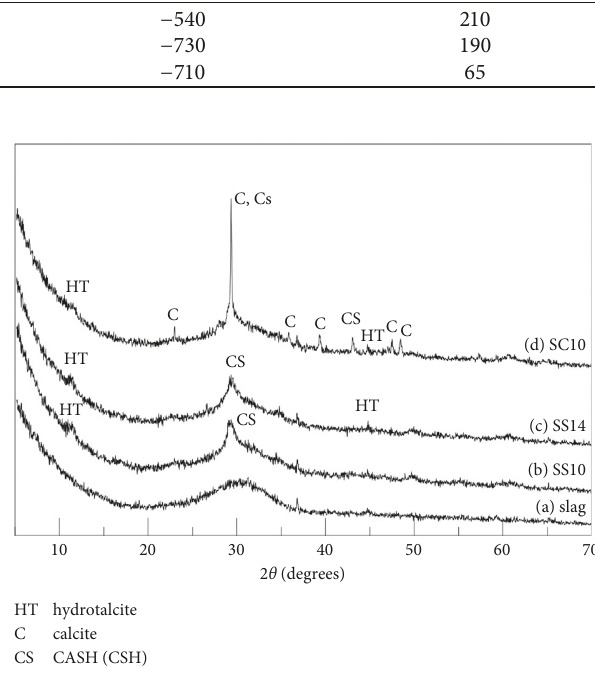
Figure 7: X-ray diffractograms at one week of age: (a) unreacted slag, (b) heat-cured SS10, (c) heat-cured SS14, and (d) heat-cured